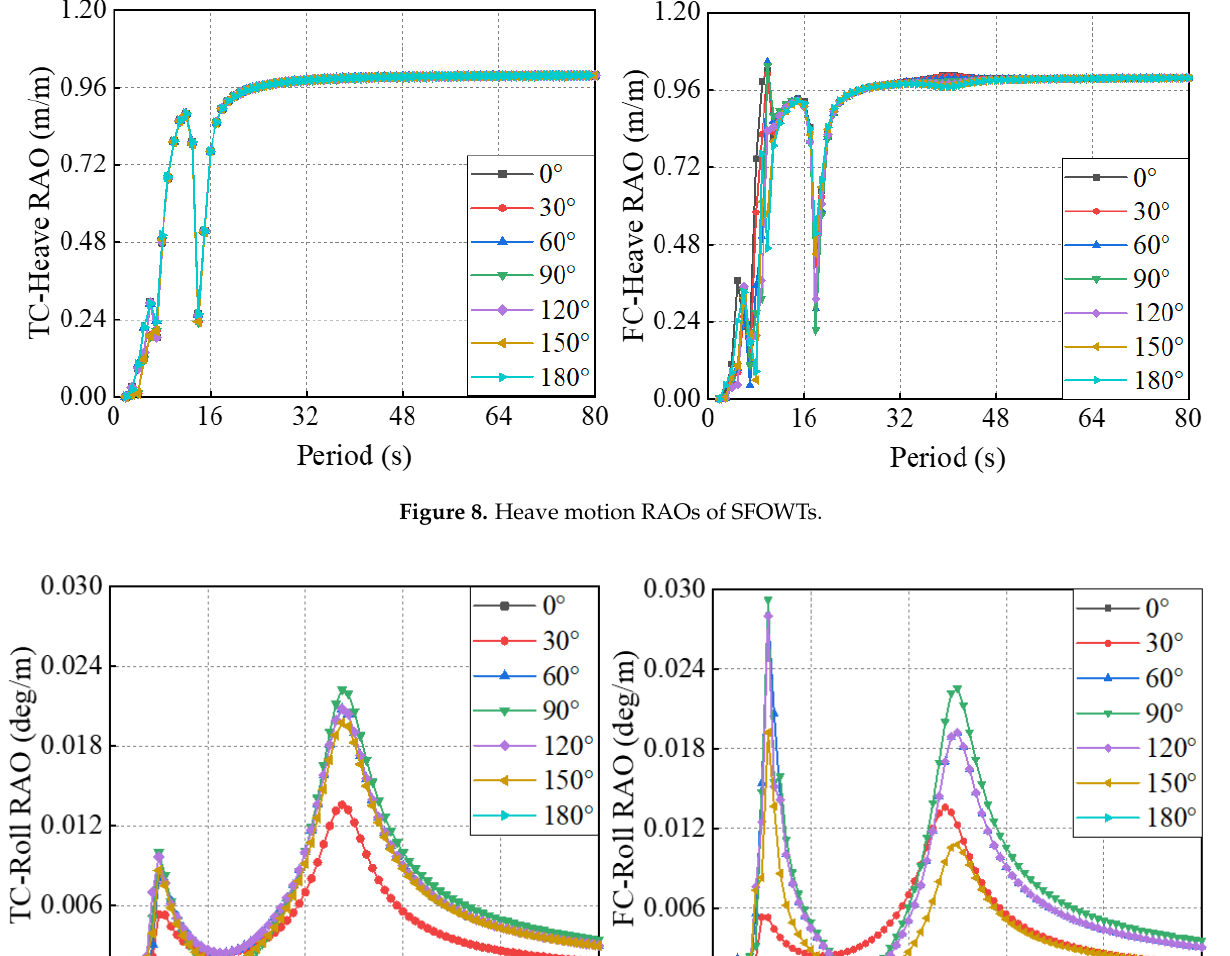
Figure 10. Pitch RAOs of SFOWTs. 5.2. Viscous Damping The RAOs of SFOWTs were calculated based on the potential flow theory, and there- fore, only the potential damping of the SFOWTs was considered and the viscous damping was ignored, which leads to a larger calculation result than the actual value of RAOs in six DOFs (degree of freedoms). In order to make the calculation results subsequently more accurate, this paper calculated the viscous damping of SFOWTs to correct the calculation process. In this paper, the method in reference [27] was adopted, and 10% of the critical damping was taken into account. The inertial mass, added mass, and restoring stiffness